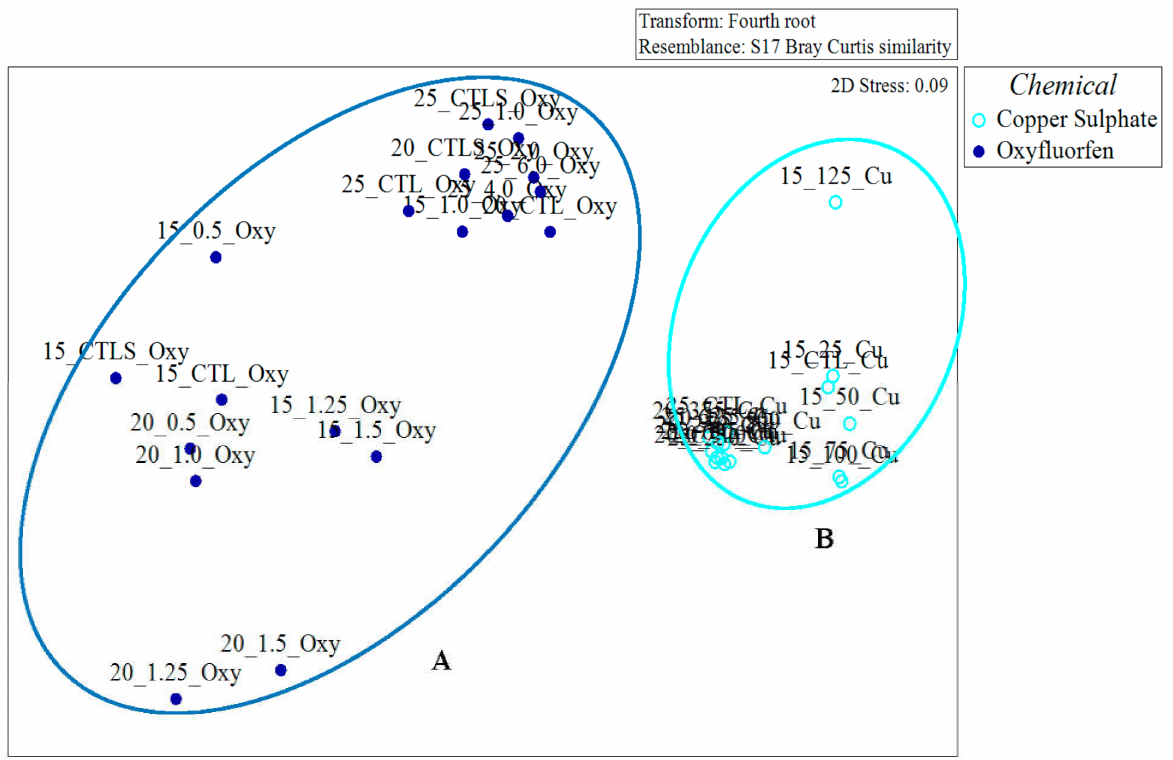
Figure 2. Two-dimensional non-metric MDS ordination plot of the FA contents of the organisms exposed to both chemicals (oxyfluorfen and copper sulfate) at the three temperatures (15 ◦ C, 20 ◦ C, and 25 ◦ C). The full gray circles represent the organisms exposed to oxyfluorfen (Group A: 15 ◦ C and 20 ◦ C—CTL, CTLS, 0.50, 1.00, 1.25, and 1.50 µ g/L; 25 ◦ C—CTL, CTLS, 1.00, 2.00, 4.00, and 6.00 µ g/L), and the empty circles represent the organisms exposed to copper sulfate (Group B: 15 ◦ C—CTL, 25, 50, 75, 100, and 15 µ g/L; 20 ◦ C—CTL, 125, 250, 375, 500, and 625 µ g/L; 25 ◦ C—CTL, 250, 500, 625, and 750 µ